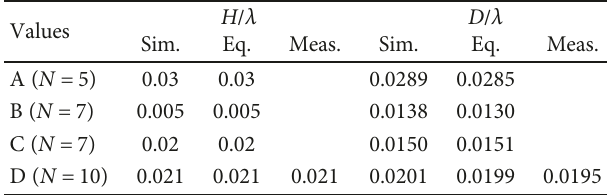
Table 3: NMHA structures chosen for